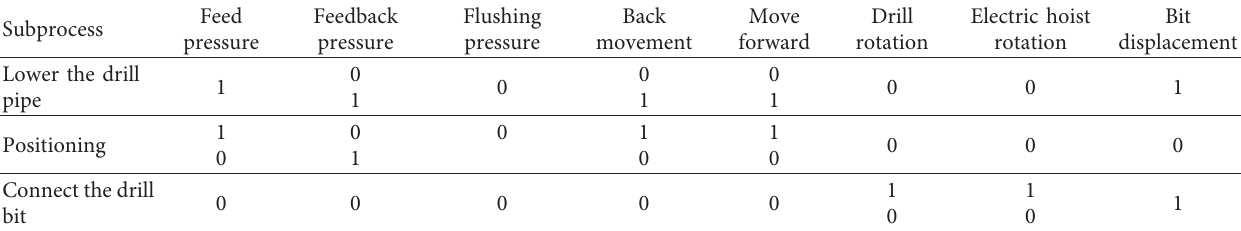
Table 3: The status of each working parameter of the drill pipe connection process.